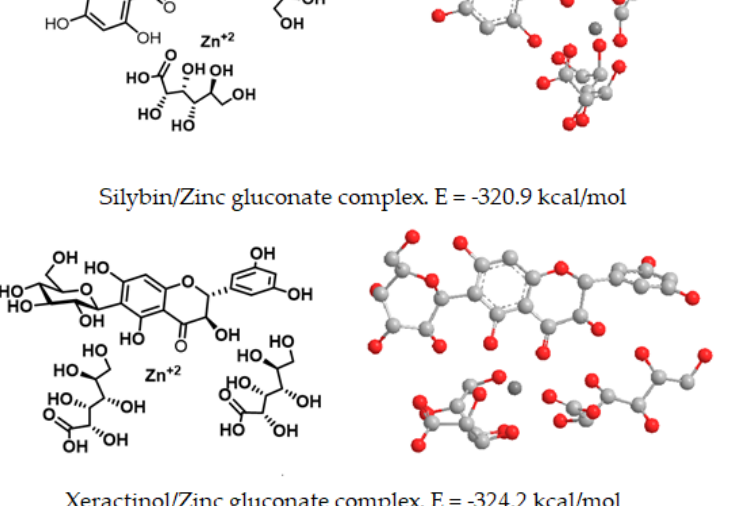
Figure 11. Energy content and spatial orientation of polyphenols silybin, xeractinol and hesperidin both in free forms ( a ) or in complexes with zinc gluconate ( b ). Light grey balls represent carbon atoms. Red balls represent oxygen atoms. Non linked dark grey balls represent zinc cations.